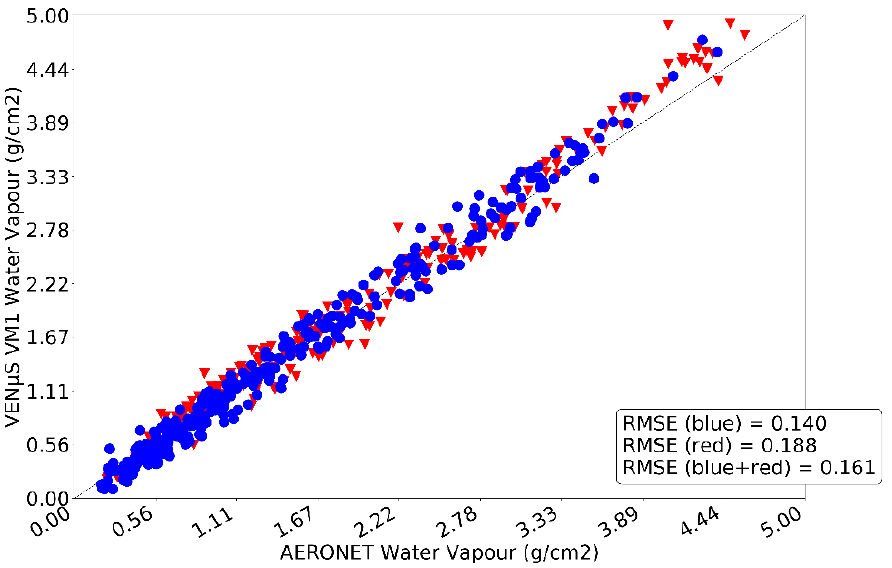
Figure 28. Quality assessment of Level-2 water vapor content estimation by comparison to concomi- tant AERONET measurements. In blue, concomitant VEN µ S and AERONET measurements with high confidence comparison criteria; in red, medium confidence comparison criteria.